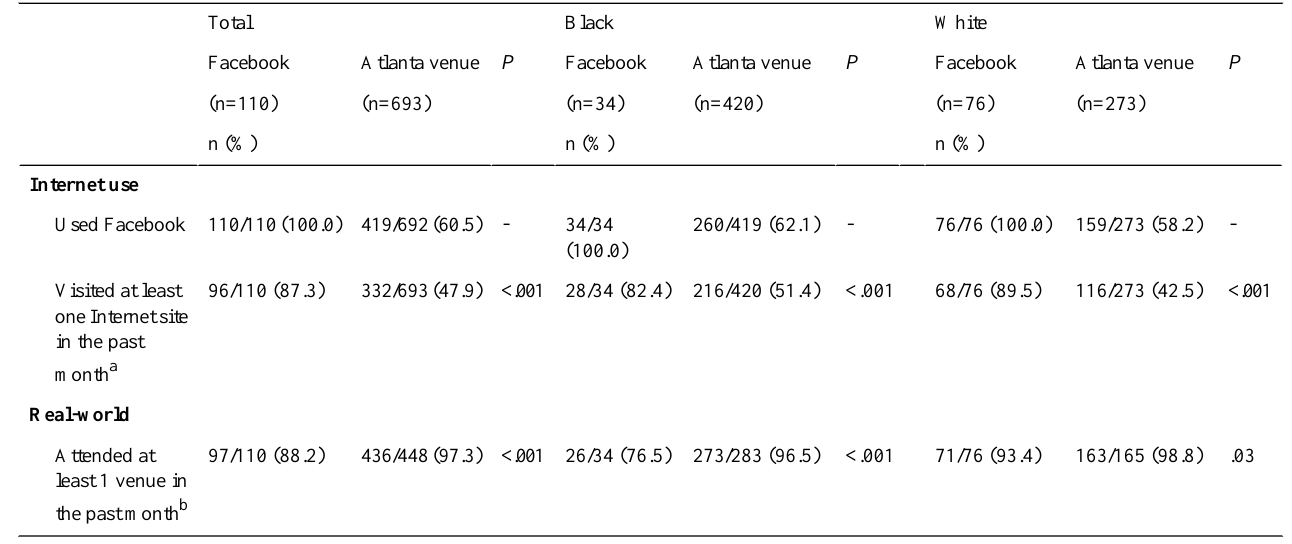
Table 1. Internet use and real-world venue attendance in the previous month by recruitment type (Facebook vs Atlanta Venues) and race, InvolveMENt, Atlanta, GA.